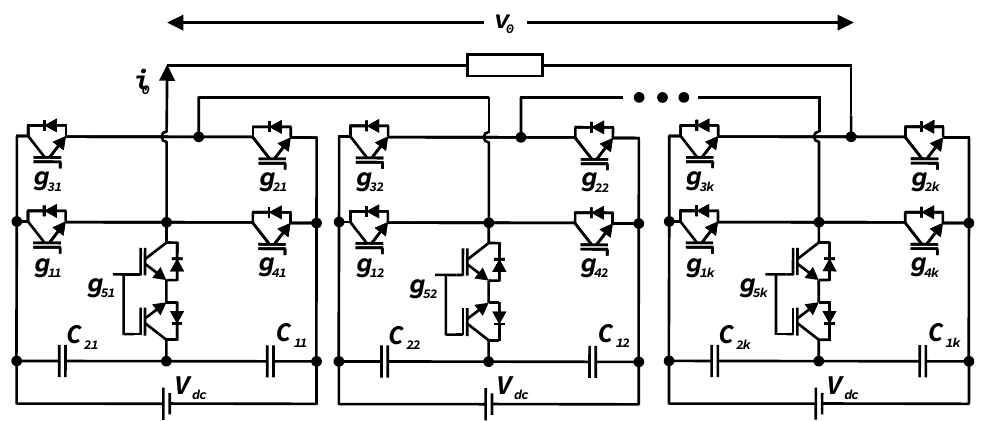
Figure 2. Cascaded 5-level switch-clamped inverter MLI .